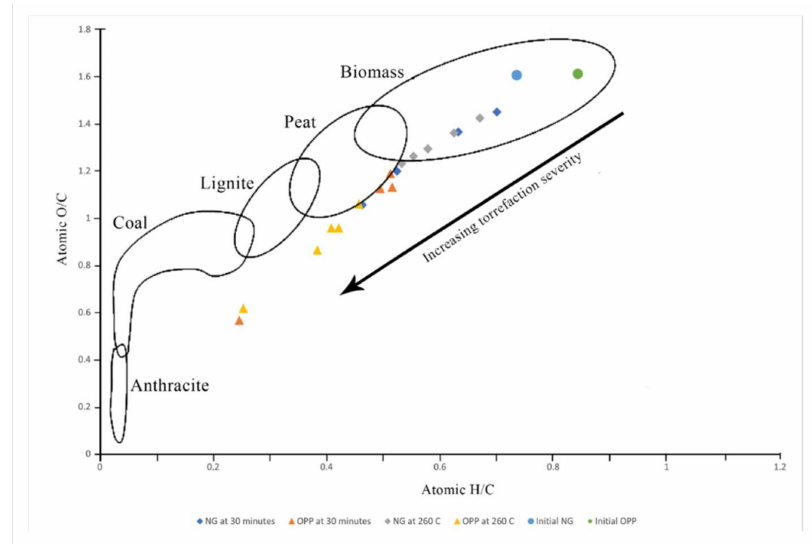
Figure 9. Van Krevelen diagram of the torrefied